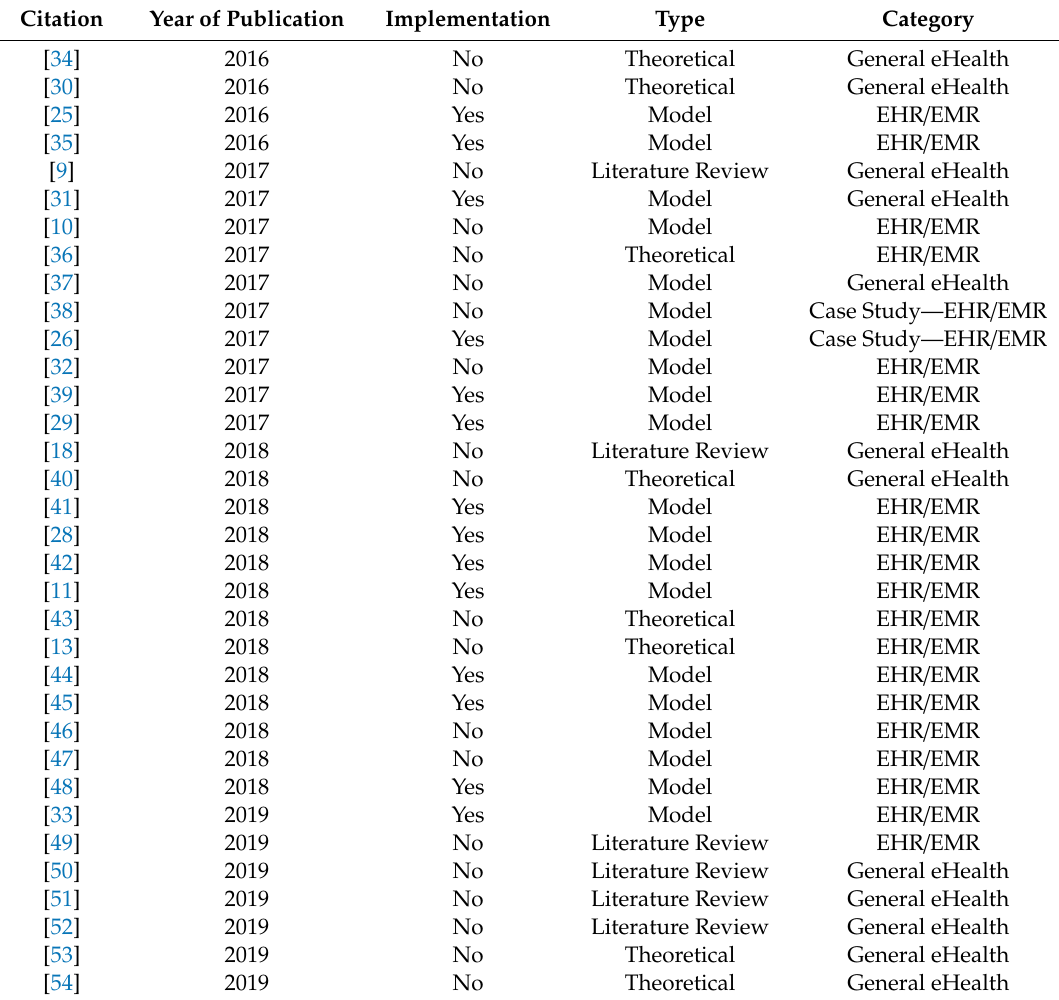
Table 2. List of publications reviewed.